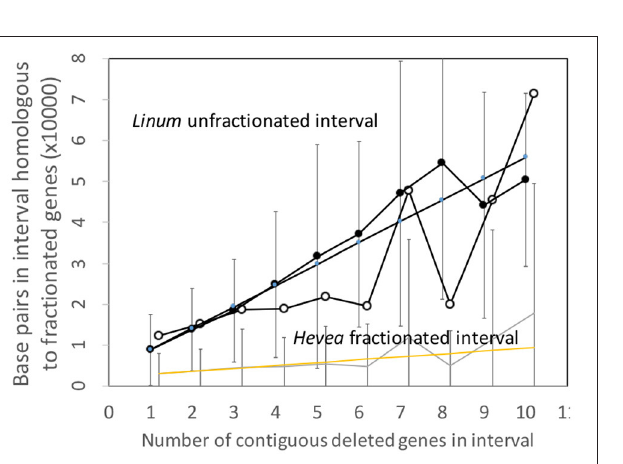
FIGURE 5 | Comparison of DNA content in unfractionated and fractionated (conserved and reduced) intervals in the Linum and Hevea genomes.